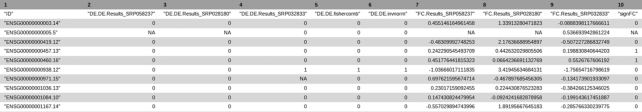
Header of a metaRNAseq results file.